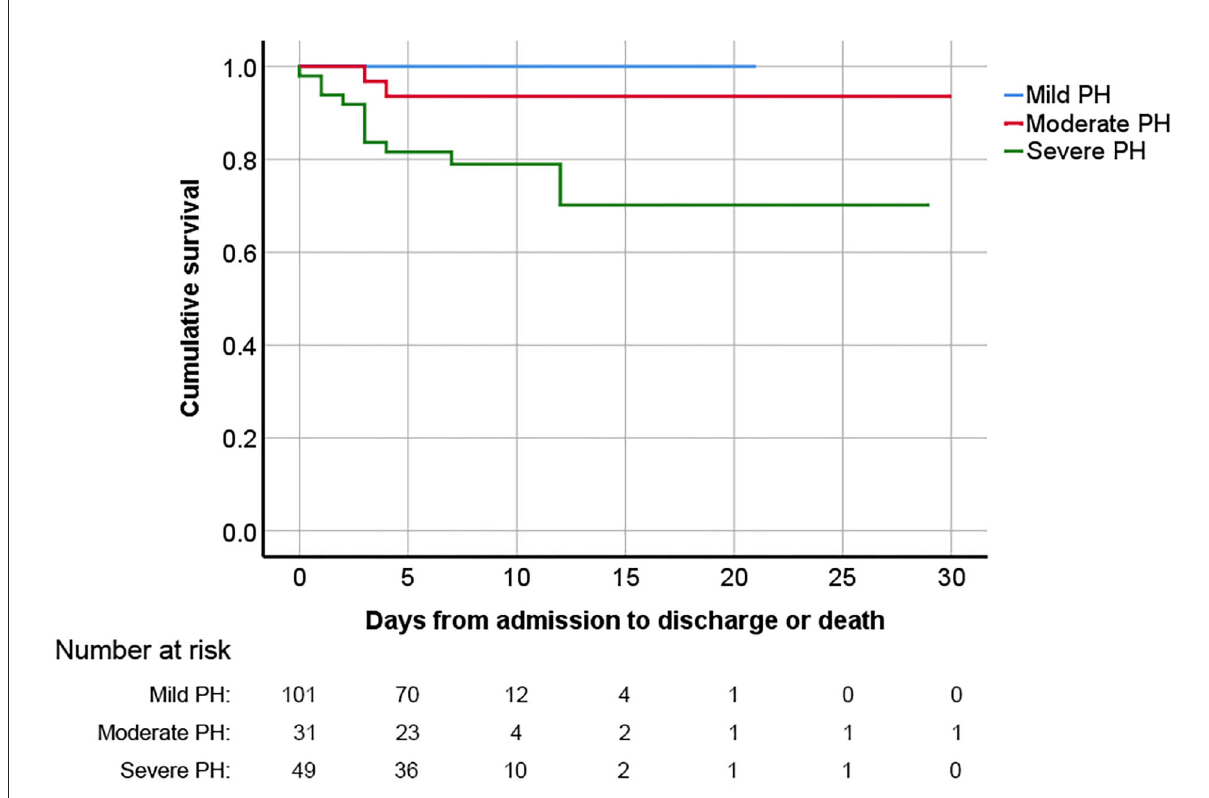
FIGURE3 Kaplan–Meier survival analysis curve for pregnant women with PH diagnosed via echocardiography based on PH severity. PH, pulmonary